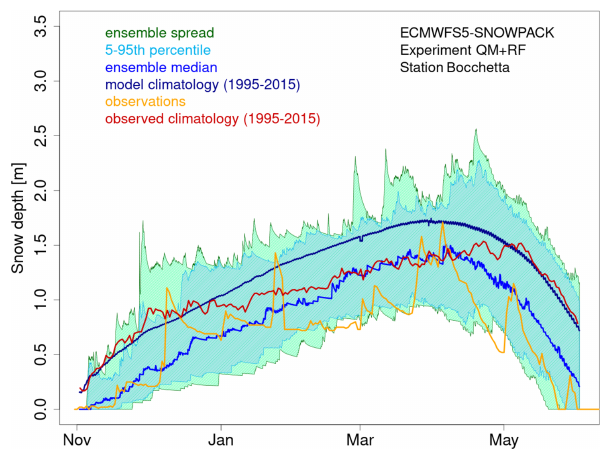
Figure 12. Seasonal forecast of snow depth obtained from the SNOWPACK model driven by the SEAS5 seasonal forecast system data. The forecast, initialized on 1 November 2006 and covering the 7 following months, refers to the station of Bocchetta delle Pisse, 2410ma.s.l. (above sea level) in the northwestern Italian Alps. The green shadow shows the spread of the 250 daily snow depth forecast ensemble members, the cyan shadow represents the 5th–95th per- centile range of the forecast distribution, the blue line represents the ensemble median of the 250 ensemble members for the 2006/2007 season, the dark blue line represents the model climatology (mean over the seasons 1995–2015 and over all ensemble members), the red line represents the observed climatology, and the orange line represents the station observations for the 2006/2007